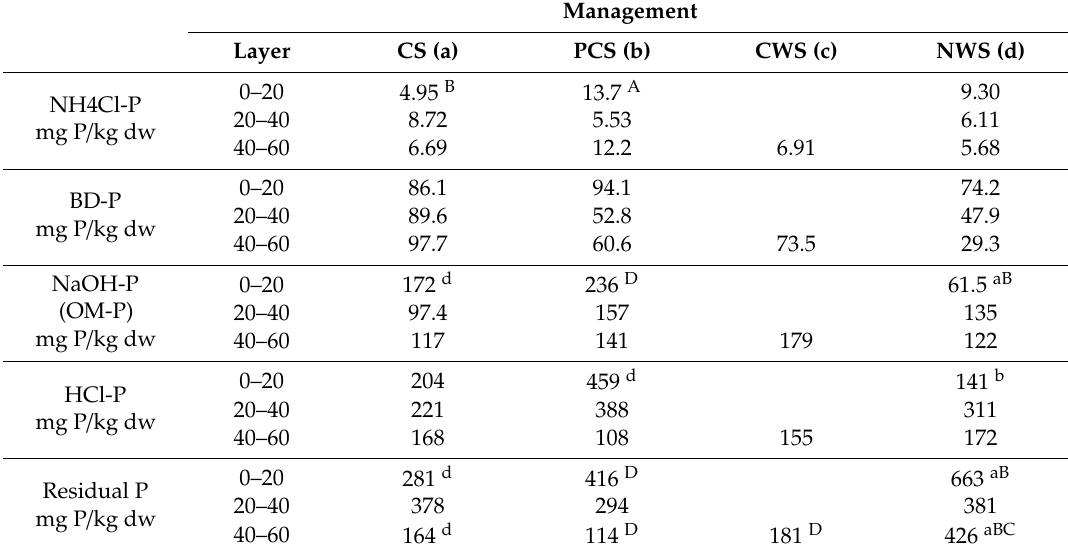
Table 5. ANOVA of the di ff erent phosphorus fractions expressed in mg P / kg dw. Statistically significant di ff erences between the respective sites and depths are indicated by superscript indices that denote the significantly di ff erent site: a = CS; b = PCS; c = CWS; d = NWS. Statistically significant di ff erences, with p < 0.01, are indicated by uppercase letters and those with 0.01 < p < 0.05 are indicated by lowercase